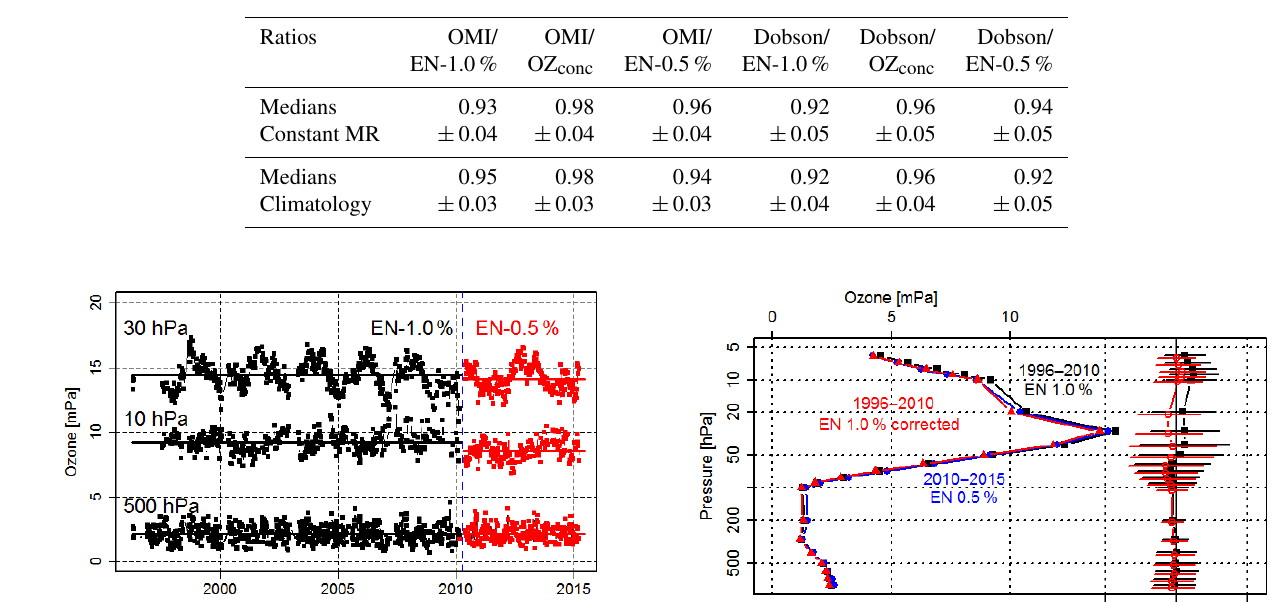
Table 4. Ratios of total column ozone at Nairobi, Kenya, measured either with the OMI satellite instrument or a Dobson spectrophotometer, compared to EN ozonesondes using 1.0 and 0.5% KI concentrations. The ratios are also shown after correction of the EN-1.0% to EN- 0.5% (OZ conc ) . Two approaches for the residual ozone column above the balloon burst are given: constant mixing ratio (MR) and using climatology (McPeters and Labow, 2012), the WMO recommendation.